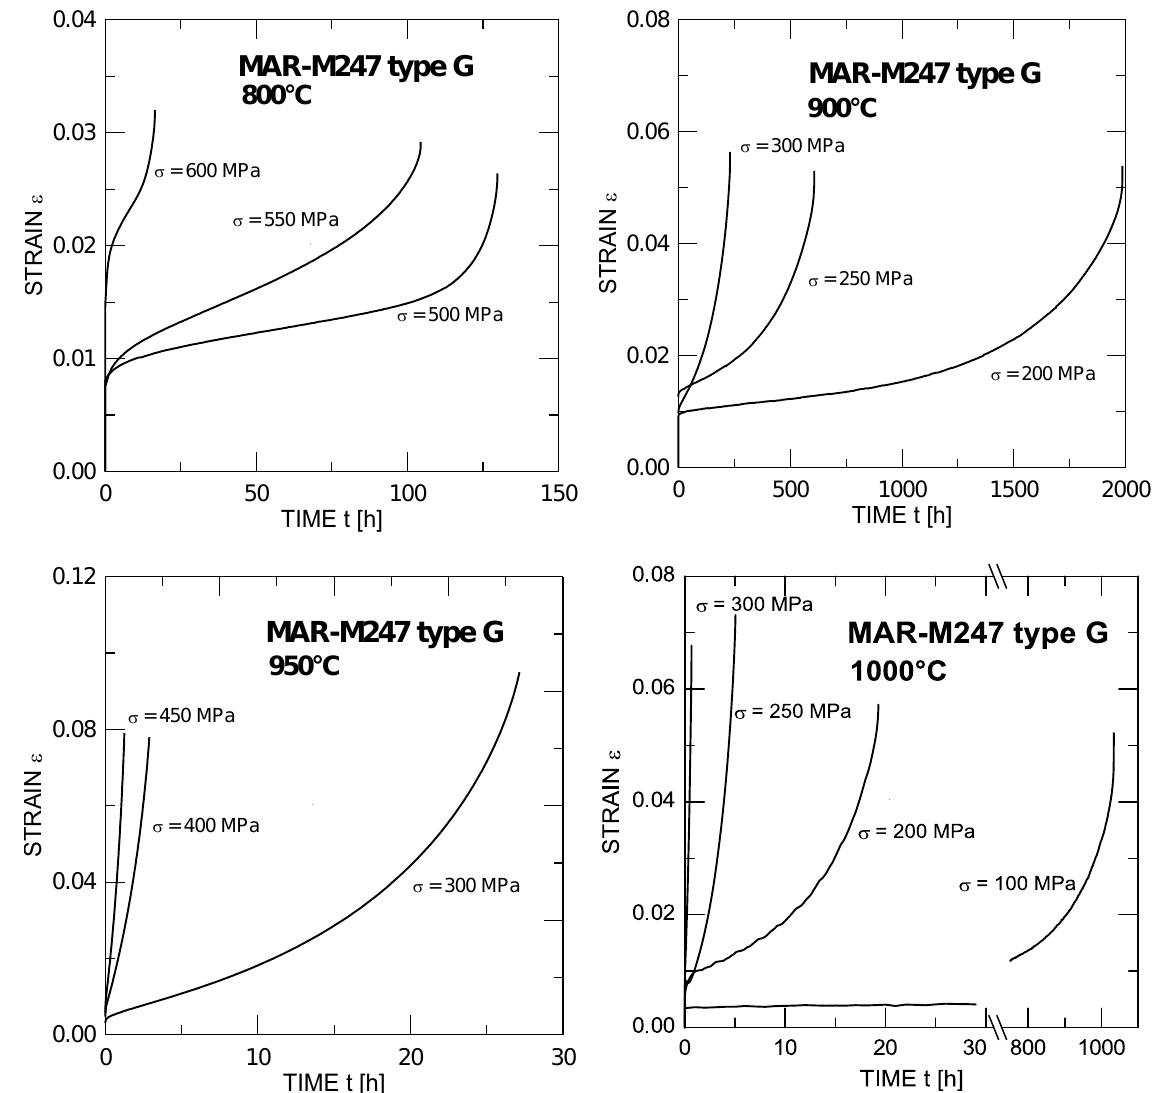
Figure 1: Representative creep curves for the superalloy MAR-M247 alloy G - the time dependence of creep strain obtained at temperatures ranging 800-1000 ∘ C at different levels of applied